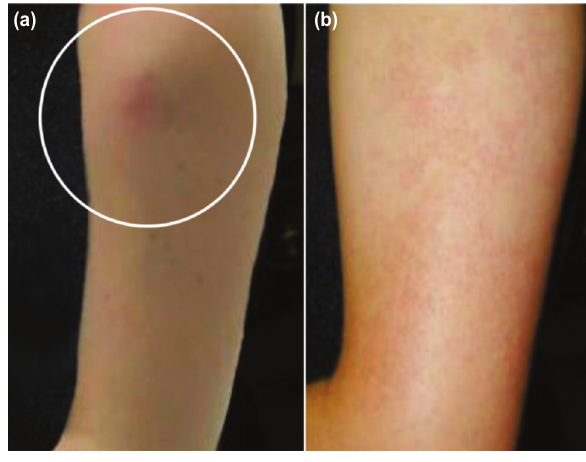
(a) Pre-treatment clinical photograph and (b) Clinical Fig. 1: photograph after treatment.